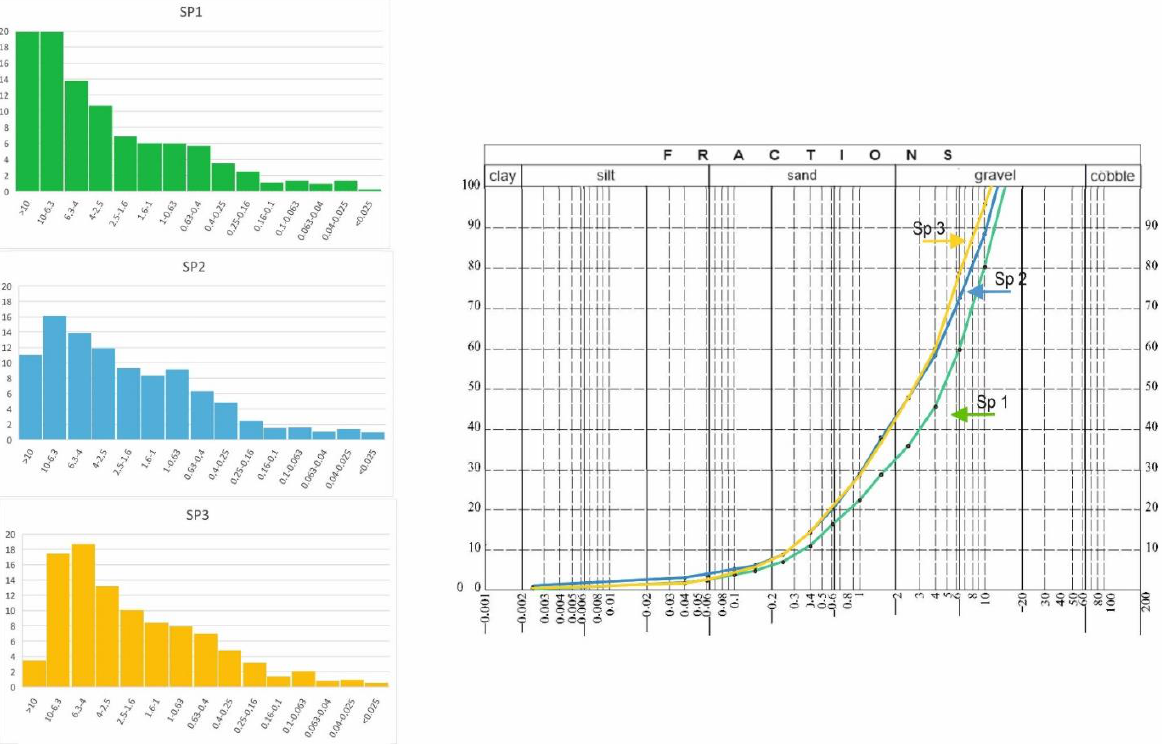
Figure 5. Cumulative curves and histograms on the basis of grain size analysis from three groups of slag.